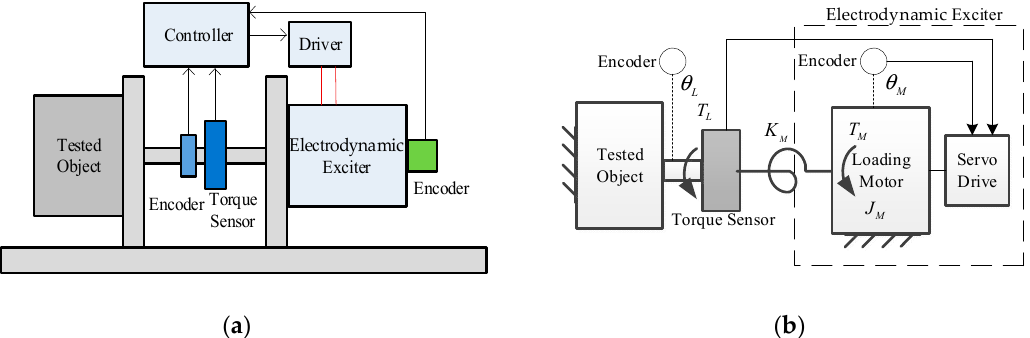
Figure 1. Dynamic torsional stiffness test with an electrodynamic exciter: ( a ) Principle; ( b ) Simplified diagram.